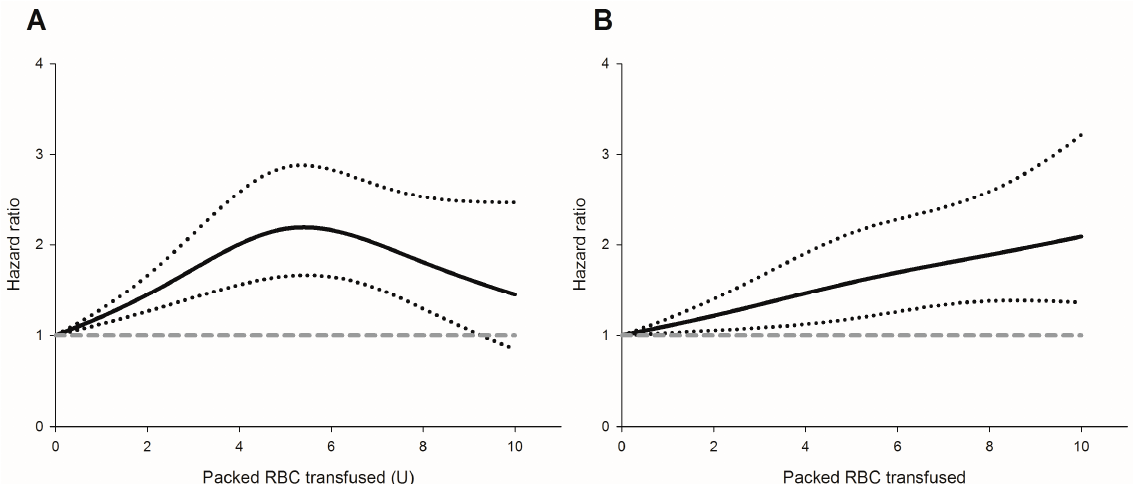
Figure 3. The packed red blood cell transfusion showed a dose-dependent risk for ( A ) cancer recurrence; ( B ) all-cause mortality. Hazard ratio (solid line); 95% confidence intervals (dotted lines); a reference of hazard ratio = 1 (dashed line).